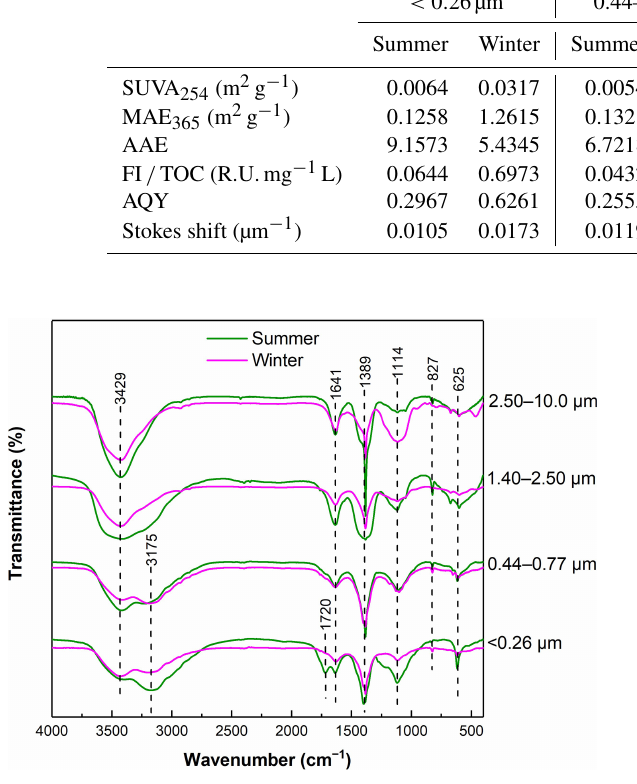
Figure 1. FTIR spectra of WSOC in particles of different sizes in summer and winter at raw pH.